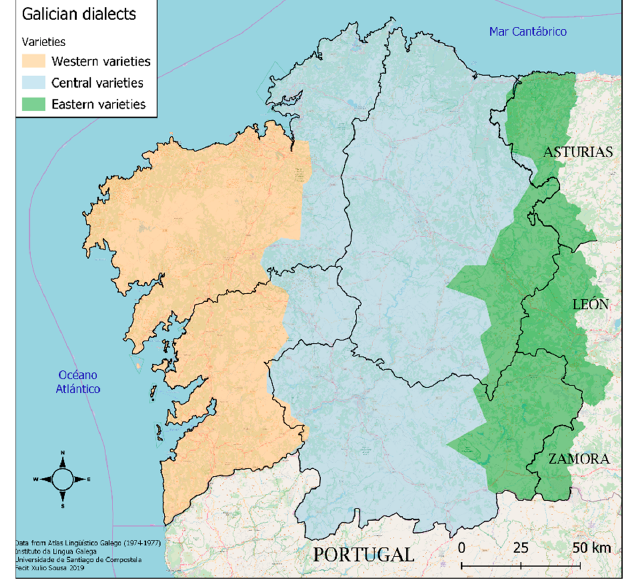
Figure 2. Galician dialectal regions.